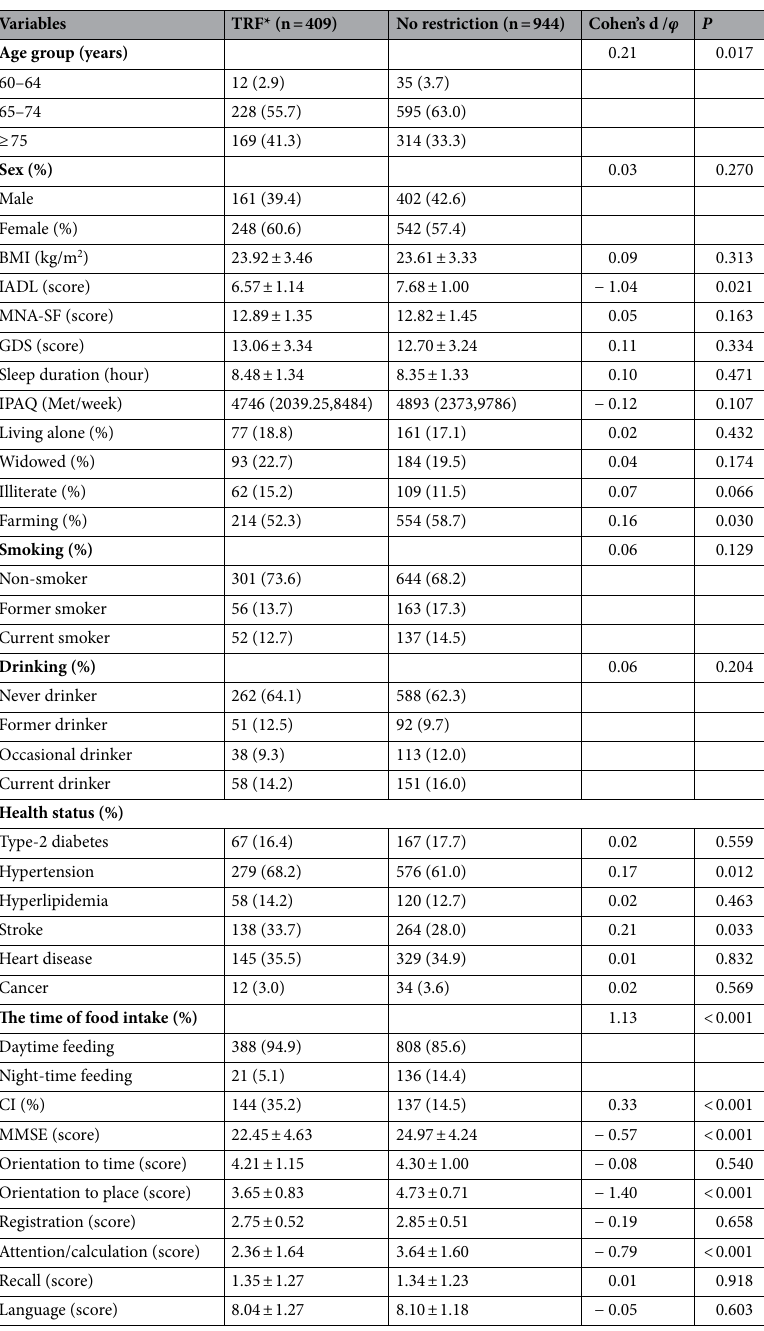
Table1. Background characteristics of the study population according to eating time window duration (time feeding restricted to 10 h vs. no restriction). TRF Time restricted feeding, BMI Body Mass Index, IADL Instrumental activities of daily living, MNA-SF Mini-nutritional assessment short-form, GDS Geriatric Depression Scale, IPAQ International physical activity questionnaires, CI Cognitive impairment, MMSE Mini- mental State Examination. *TRF is the control group. △ Cohen’s d indicates effects sizes in Student’s t-test and Mann–Whitney U-test, φ indicates effects sizes in Chi-squared